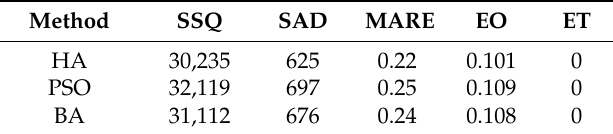
Table 9. Comparison of results based on the four-parameter Muskingum model for Karahan